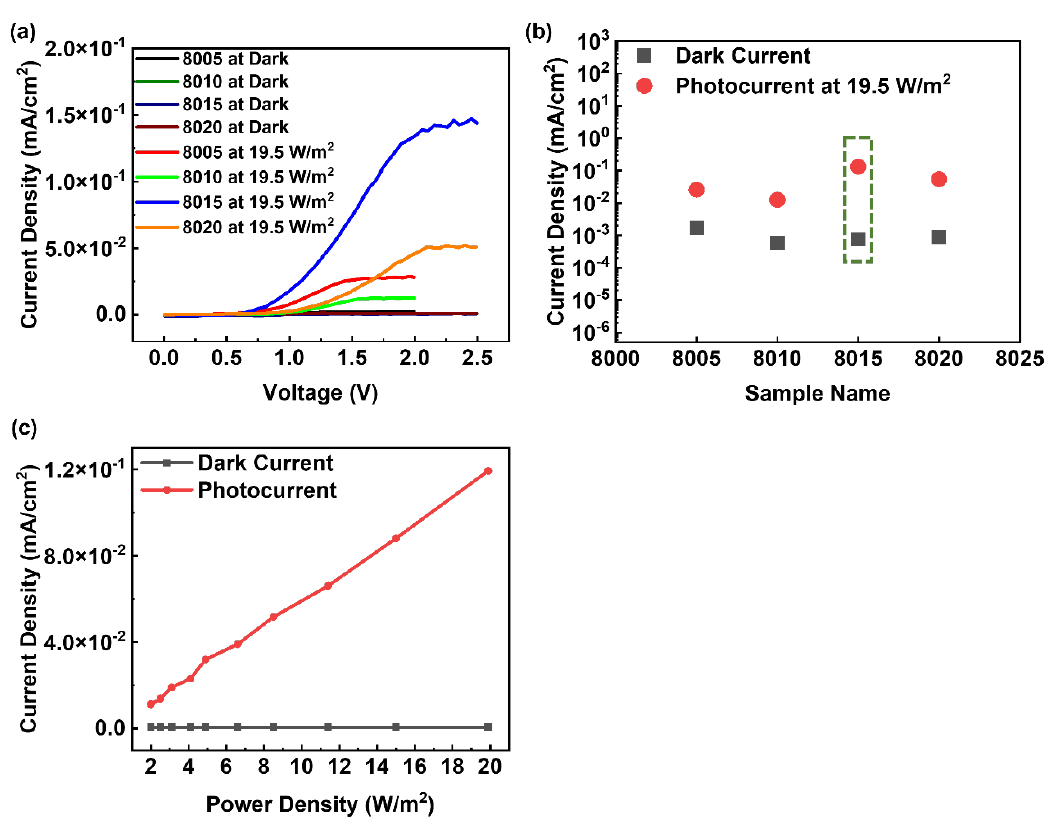
Figure 3. ( a ) The I-V characteristics of MSM broadband visible light photodetectors with different homemade conductive materials. ( b ) The current density of the flexible MSM broadband visible light photodetector with different numbered conductive Ag paste electrodes. ( c ) The current density of the flexible MSM broadband visible light photodetector with homemade numbered 8015 conductive Ag paste electrodes under different light power densities.